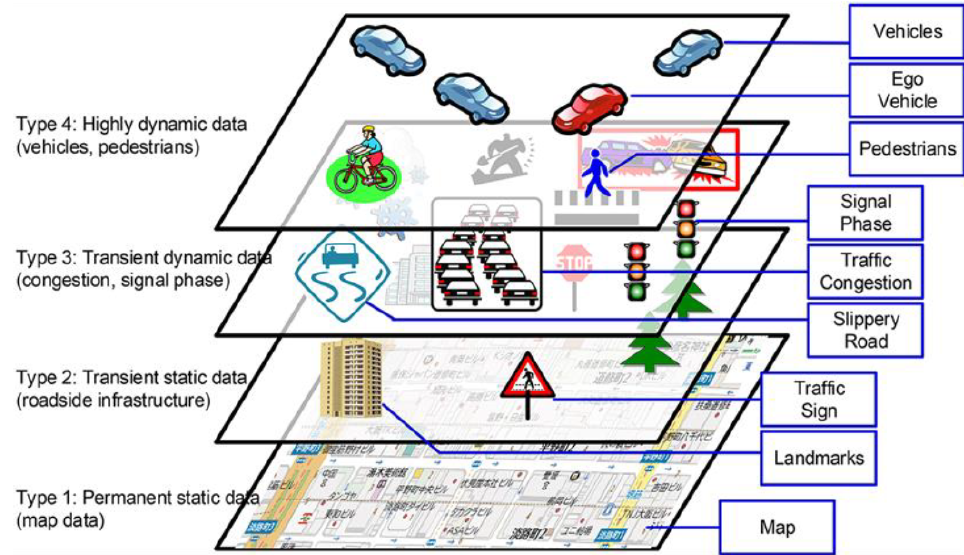
Figure 5. The four-layer local dynamic map model